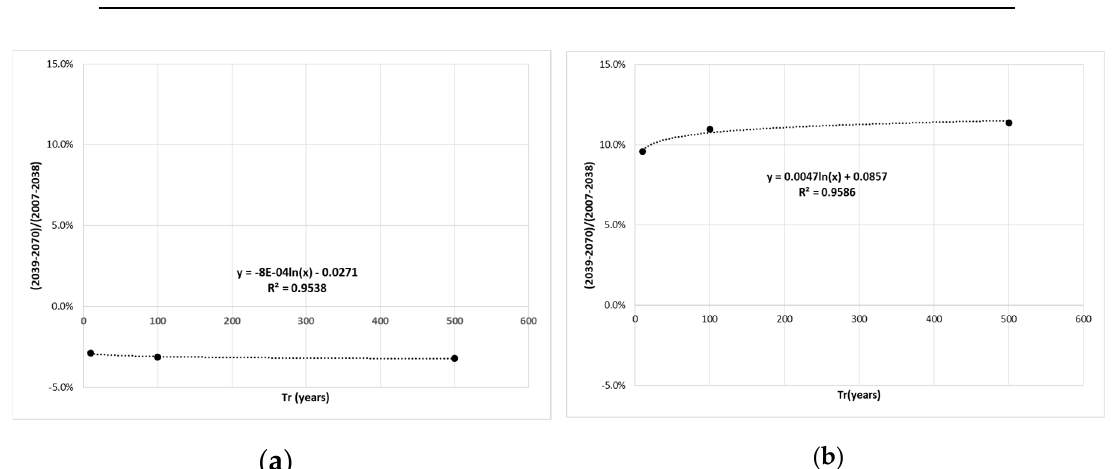
( b ) Figure 14. Second Stage (2039–2070)/1st Stage (2007–2038) inhabitants potentially affected ratio trend line in terms of return periods. ( a ) ANA—BCC-CSM1-1-m; ( b ) ANA—MRI-CGCM3. Flooded surface, inhabitants potentially affected and flood economic damage value can be calculated in absolute terms and are shown in Table 4 for ES091_HIJ_01_02_04_05_06.